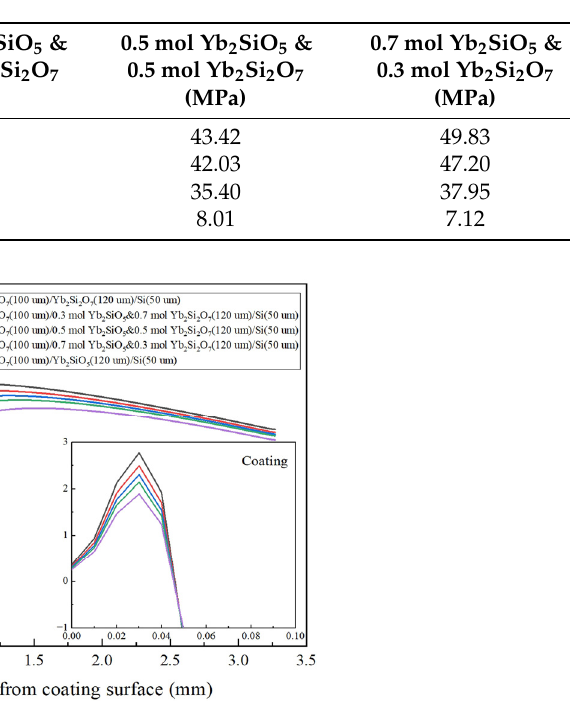
Table 4. S22_Max of each region with different Yb 2 SiO 5 contents.